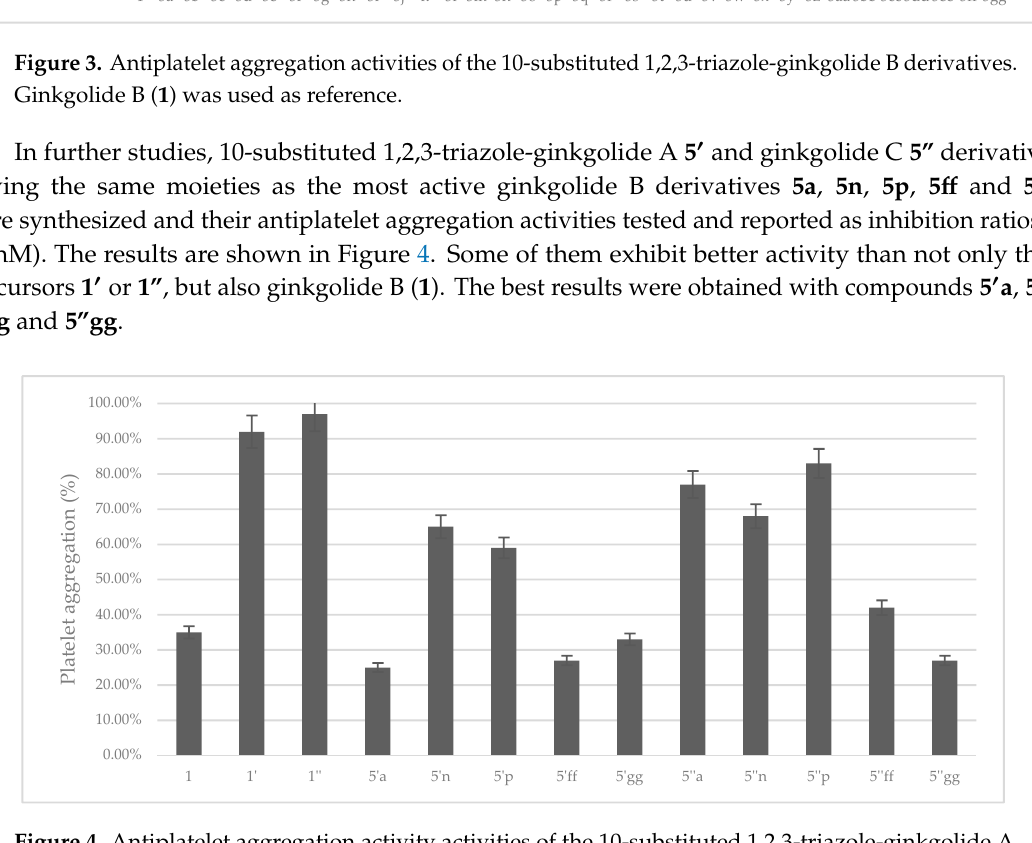
Figure 3. Antiplatelet aggregation activities of the 10-substituted 1,2,3-triazole-ginkgolide B derivatives. Ginkgolide B ( 1 ) was used as reference.